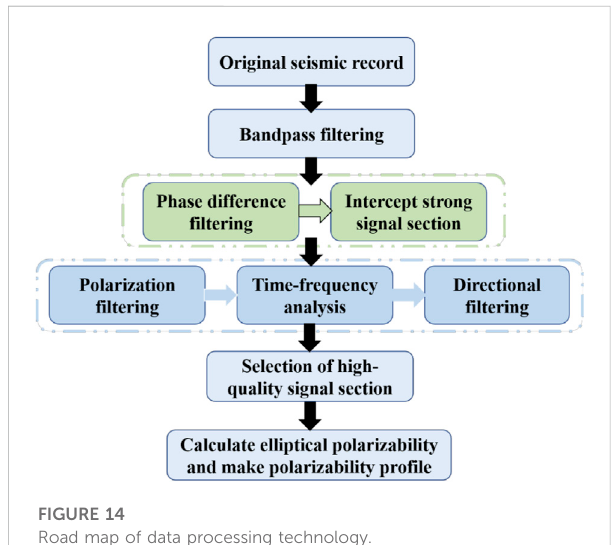
FIGURE 14 Road map of data processing